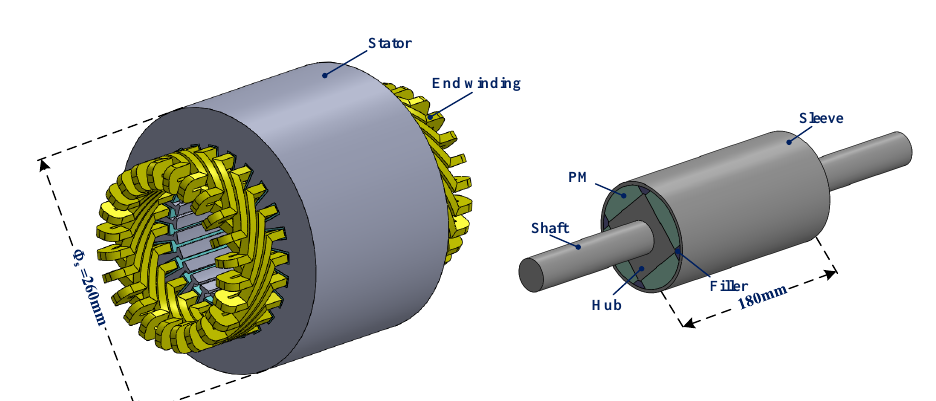
Figure 1. The 3D structure of the prototype.